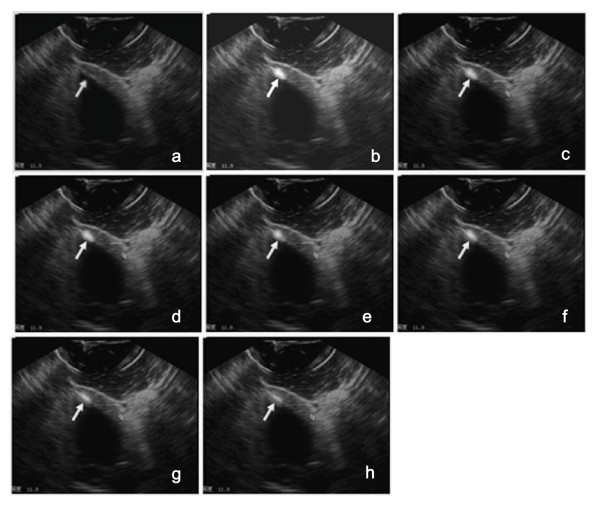
Imaging of the microbubbles at the intramyocardial injection site. EGFP plasmid DNA (100 μg) was mixed with 0.1 ml of microbubble solution and injected into the myocardium of the left ventricle anterior wall. (a) Long-axis view before contrast injections. (b) The same long-axis view showing contrast injection at 5 min (indicated by the white arrow); the contrast is visible as the hyperintense signal indicated by the white arrow. (c) Long-axis view showing contrast injection at 10 min. (d) Long-axis view showing contrast injection at 20 min. (e) Long-axis view showing contrast injection at 30 min. (f) Long-axis view showing contrast injection at 40 min. (g) Long-axis view showing contrast injection at 50 min.(h) Long-axis view showing contrast injection at 60 min.